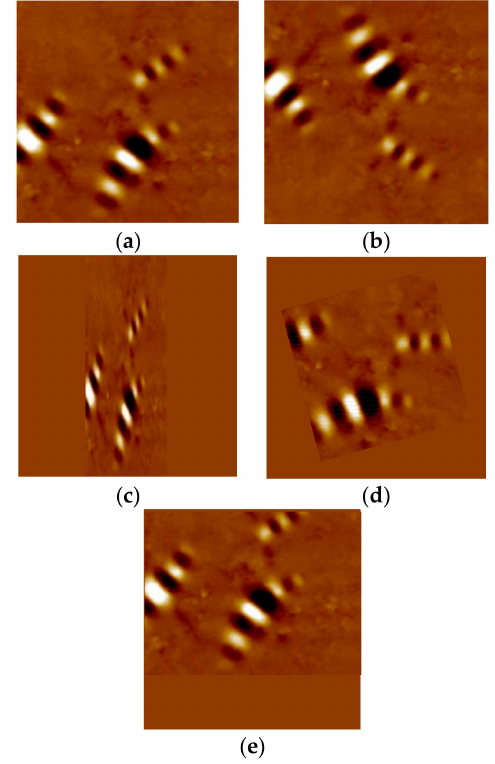
Figure 8. Examples of data augmentation; ( a ) original image, ( b ) flipping, ( c ) shearing, ( d ) rotating, ( e )